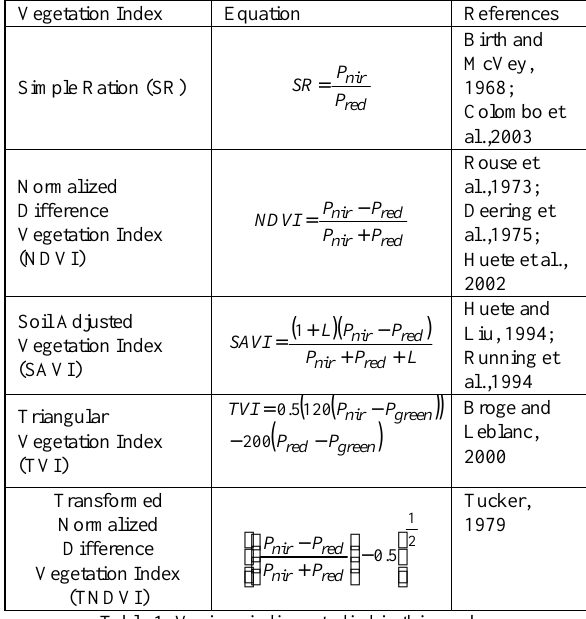
Table 1: Various indices studied in this